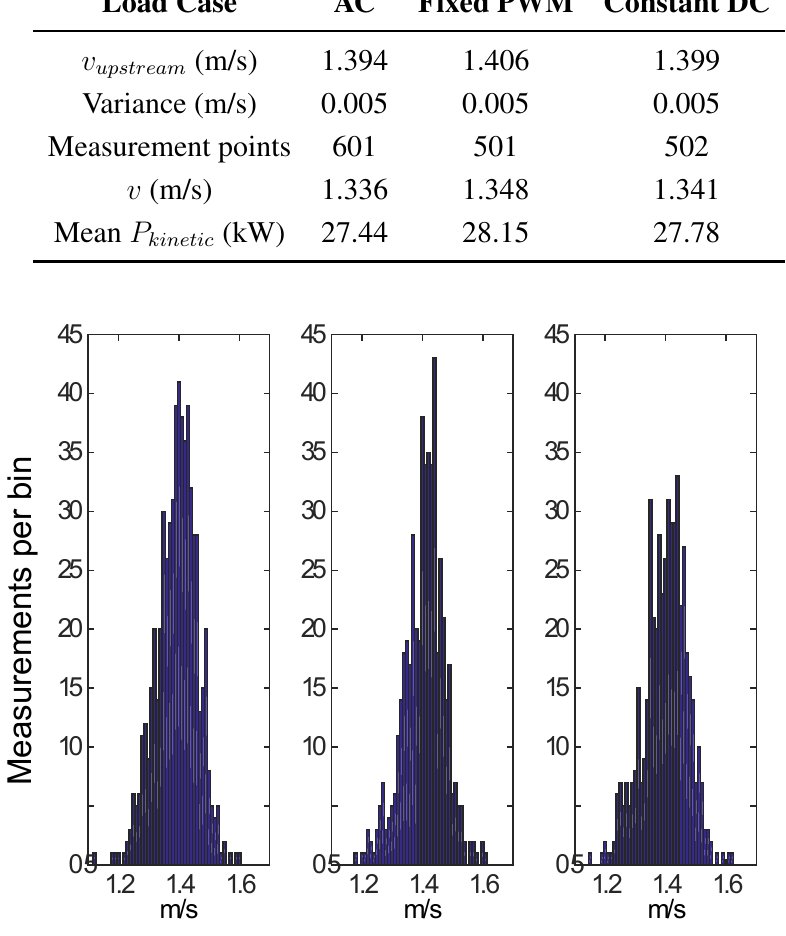
Figure 8. Histogram of water speed during load conditions. From left to right: AC load, fixed PWM and constant